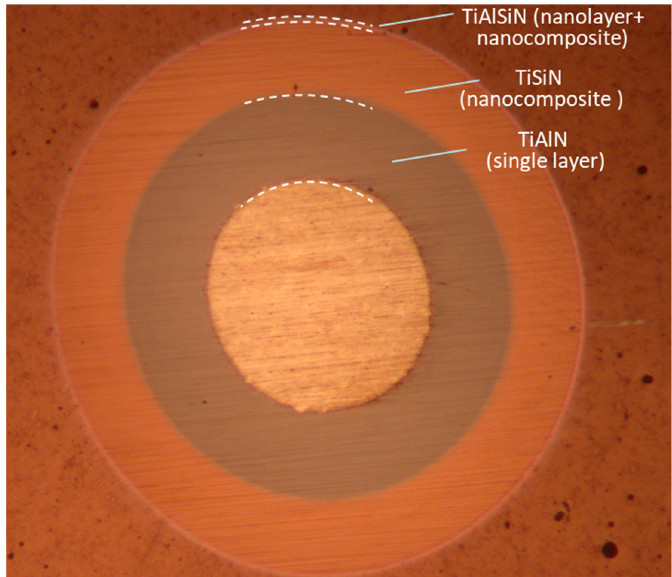
Figure 1. Optical image of ball crater (calotte) through entire »TiAlSiN« hard coating [27].